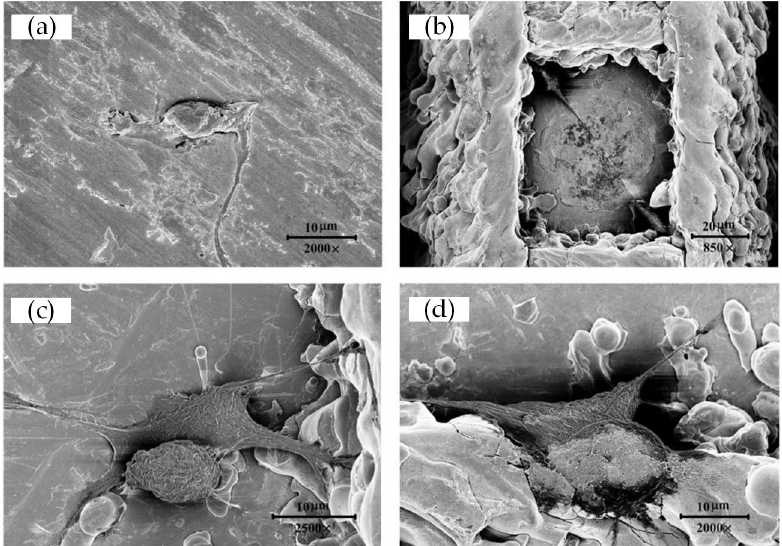
Figure 6. SEM picture of MC3T3-E1 cells morphology grown on the surface of samples (22 h): ( a ) Smooth; ( b ) Texture 1; ( c ) Texture 2; and ( d ) Texture 3.